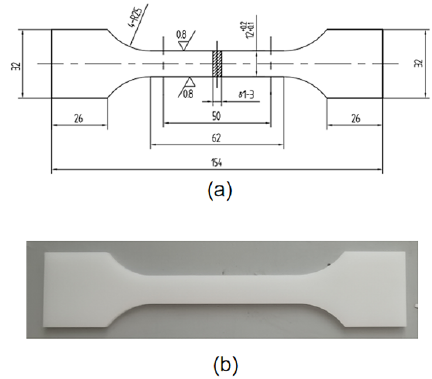
Figure 5. ( a ) Schematic diagram of the size of the specimen for the creep experiment. ( b ) Physical image of the specimen. Materials 2021 , 14 , x FOR PEER REVIEW